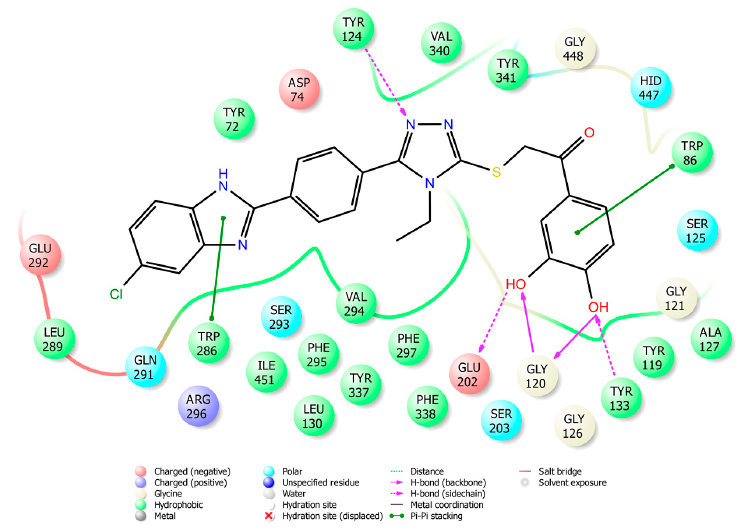
Figure 6. Two-dimensional interaction mode of compound 3h in the enzyme active site of AChE.